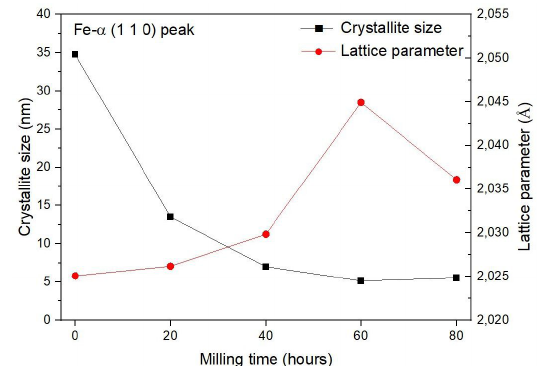
Figure 12. Crystallite size and lattice parameter as a function of different milling times for the (110) Fe-α peak for Fe-15at.%Nb samples with methanol